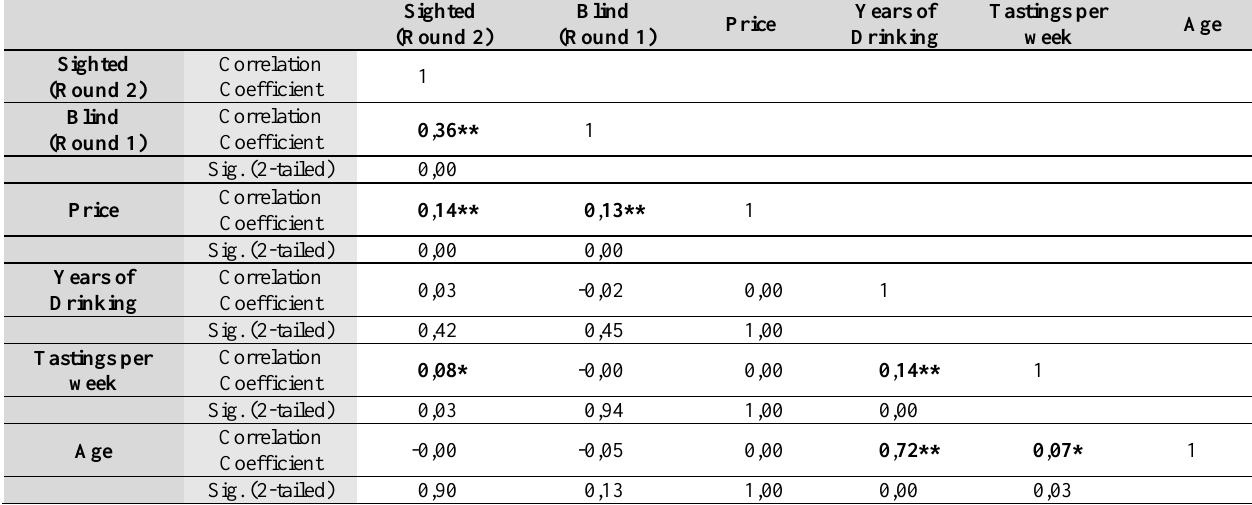
Table 2: A correlation matrix depicting variables across the entire dataset (n = 700) Sighted (Round 2)